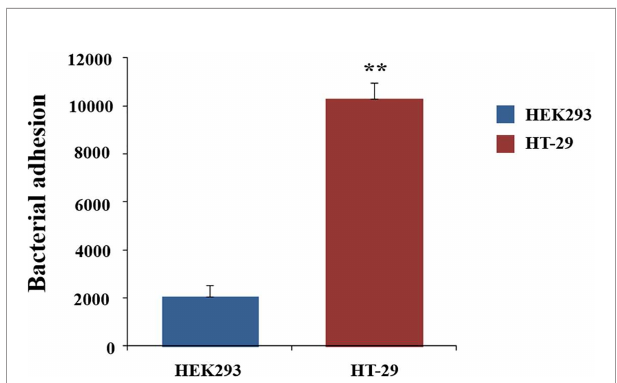
FIGURE 1 | Adhesion of C. butyricum to HEK293 and HT-29 cell line. The live bacteria were fl uorescently stained with SYTO9 and then incubated for 1h with HT-29 cells. The fl uorescence intensity was measured with the microplate reader at 528nm. HEK293 cells was used as the control. Results are expressed as means and standard deviation of three independent experiments with ** P < 0.01.